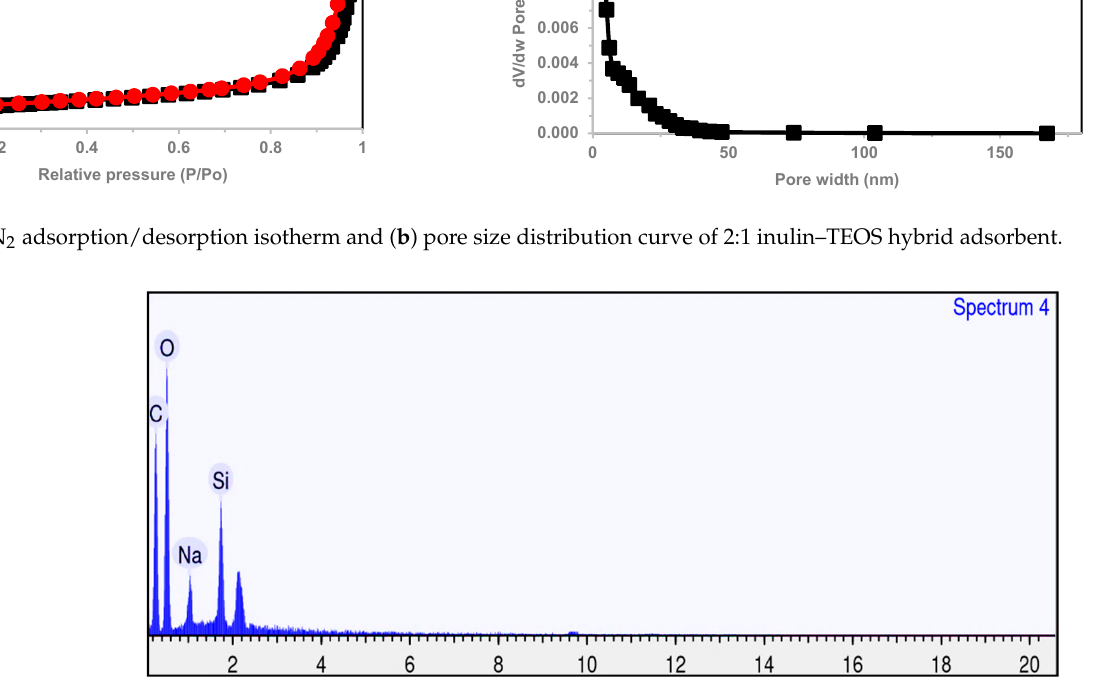
Figure 5. EDX spectra for 2:1 molar ratio inulin–TEOS hybrid adsorbent.